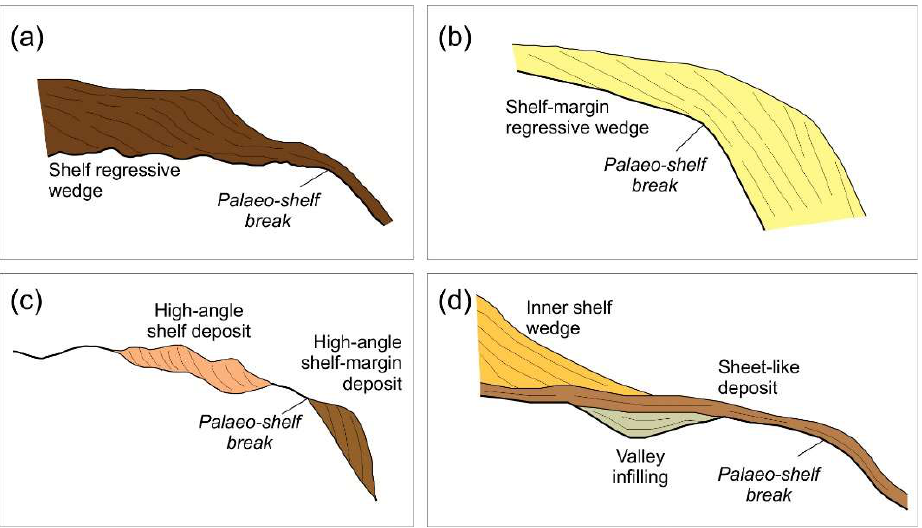
Figure 2 . Types of seismic units identified along the Mediterranean margin of the Iberian